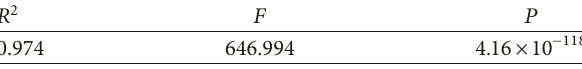
Table 6: Statistical